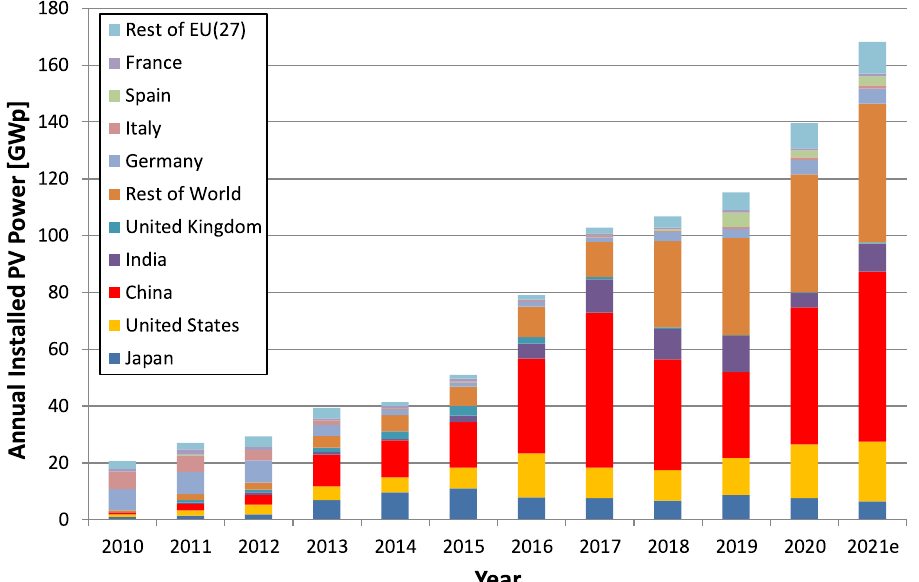
Fig. 2. Annual photovoltaic installations from 2010 to 2020 with estimate for 2021 (data source: [18 – 21] and own